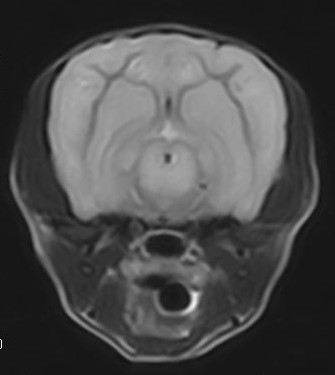
Transverse T2-weighted image (TR = 3000, TE = 90) through the midbrain of the Yorkshire terrier with L-2-HGA. The gray matter of the cerebrum and brainstem shows the symmetric hyperintensity characteristic of the disease [7,9].